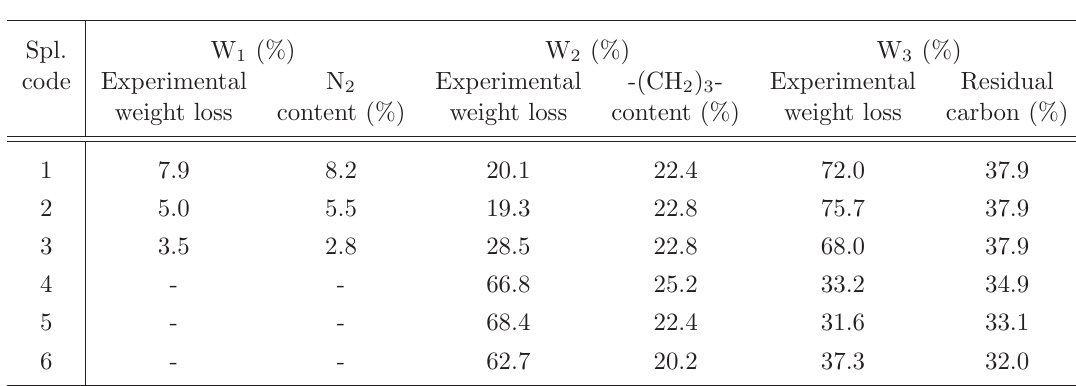
Table 3 Theoretical and experimental weight losses of the synthesized